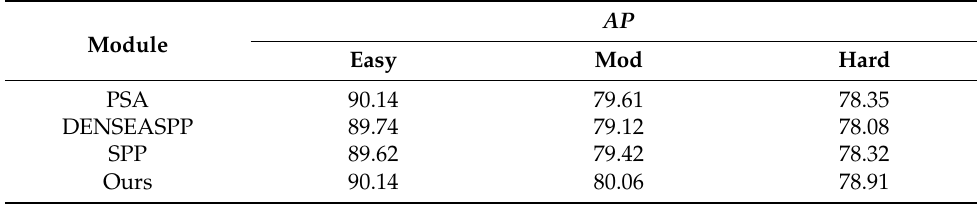
Table 5. AP of different feature extraction